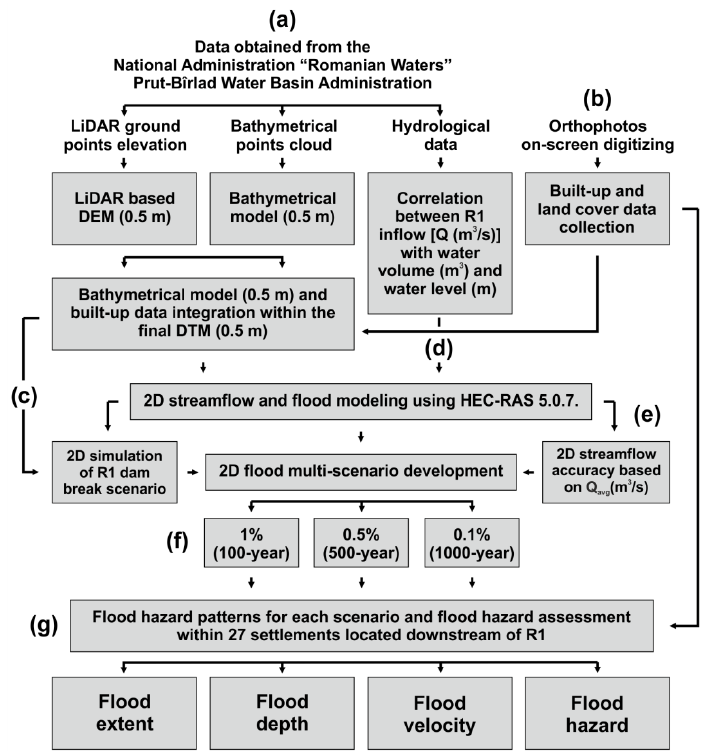
Figure 3. Workflow diagram of the 2D HEC-RAS flood modeling process in case of R1 embankment dam break scenario: ( a ) data obtained from National Administration Romanian Waters (NARW) Prut–Bîrlad Water Basin Administration (PBWBA), where LiDAR and bathymetrical data were used for generate the LiDAR-derived DTM and hydrological data (R1 inflow Q m 3 /s) to correlate the volume and water level in R1; ( b ) on-screen digitizing of land-cover data and built-up data integration; ( c ) estimation of the breach characteristics in case of R1 dam piping failure based on regression equations developed from historical dam failures; ( d ) generation of the 2D multi-scenario using HEC-RAS 5.0.7., where ( e ) Q avg was used for testing the 2D flow accuracy and ( f ) for 2D flood wave scenarios with 1% (100 years), 0.5% (500 years), and 0.1% (1000 year) recurrence intervals; ( g ) generation of the flood pattern and flood hazard assessment according to Australian Institute for Disaster Resilience (AIDR) [46].